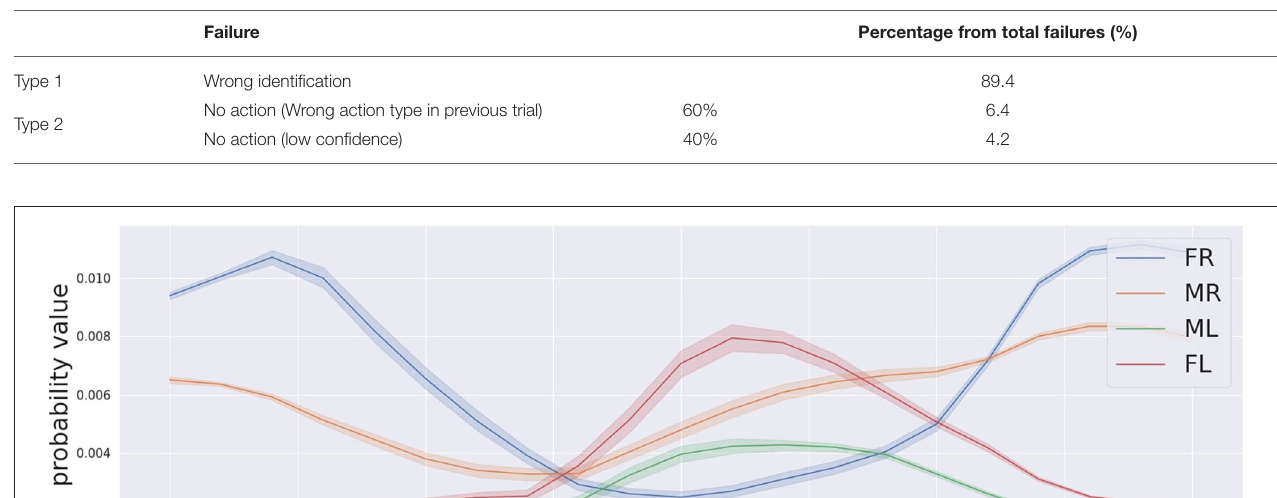
TABLE 1 | Robot’s failure types